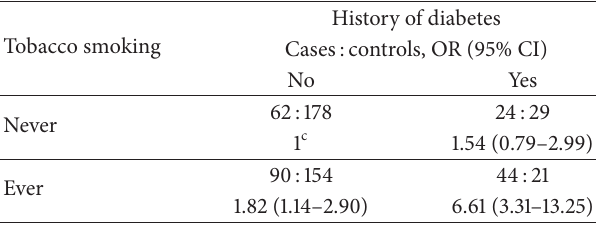
Table 3: Distribution a of 224 hepatocellular carcinoma (HCC) cases and 389 controls and corresponding odds ratios b (OR) and 95% confidence intervals (CI), according to the combination of smoking and diabetes (Italy,